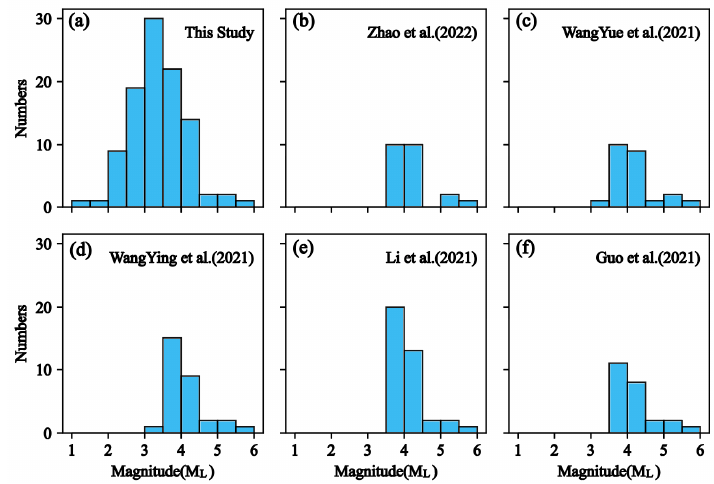
Figure 3. Statistics of the focal mechanism solutions for 1 ≤ M L ≤ 6.4. ( a – f ) denotes the magnitude distribution of the focal mechanisms obtained in this study and Refs. [52–55,57].